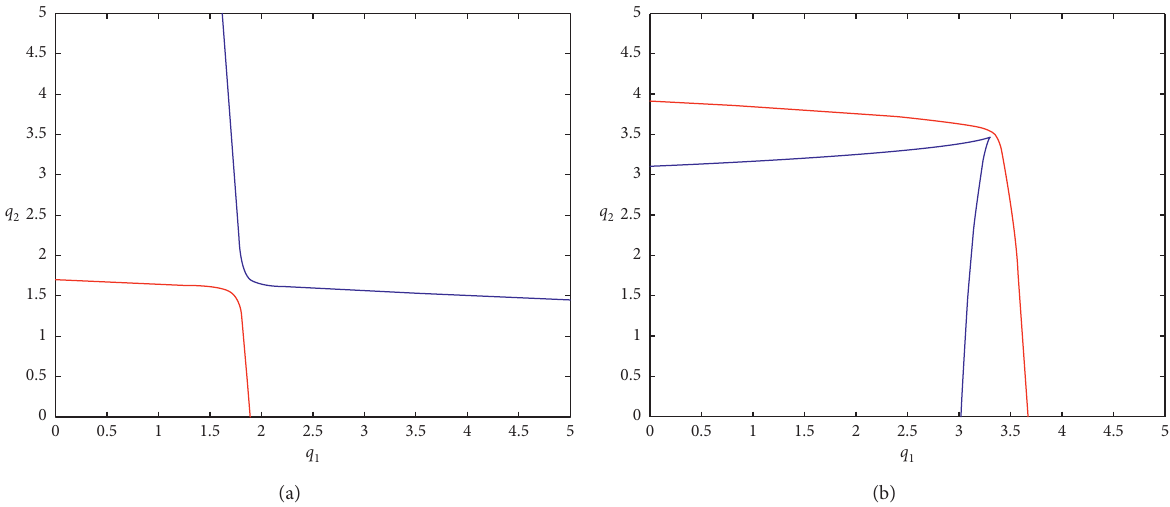
� 0 . 699, α � 0 . 191, 1 2